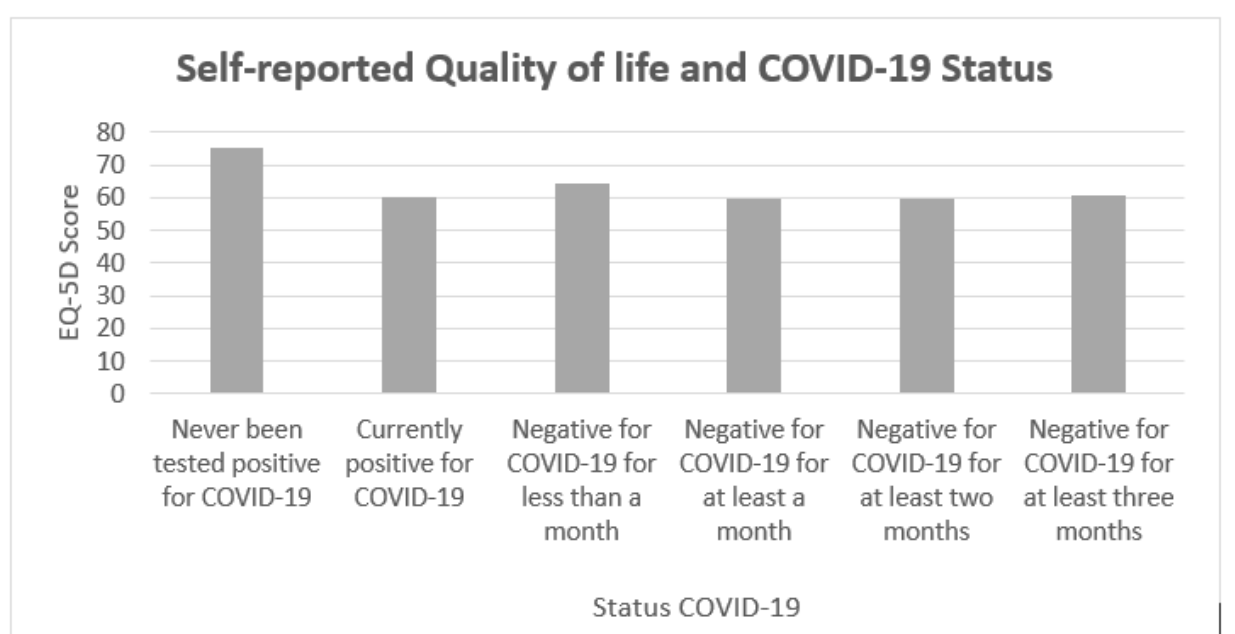
Figure 4. Mean values of the scores indicated by the subjects regarding their quality of life, classified according to the COVID-19 status. Table 6. Mean values (M) and standard deviation (SD) for subjects who responded to individual items in the five dimensions investigated by the EQ-5D, classified by COVID-19 status and EQ-5D Scale.